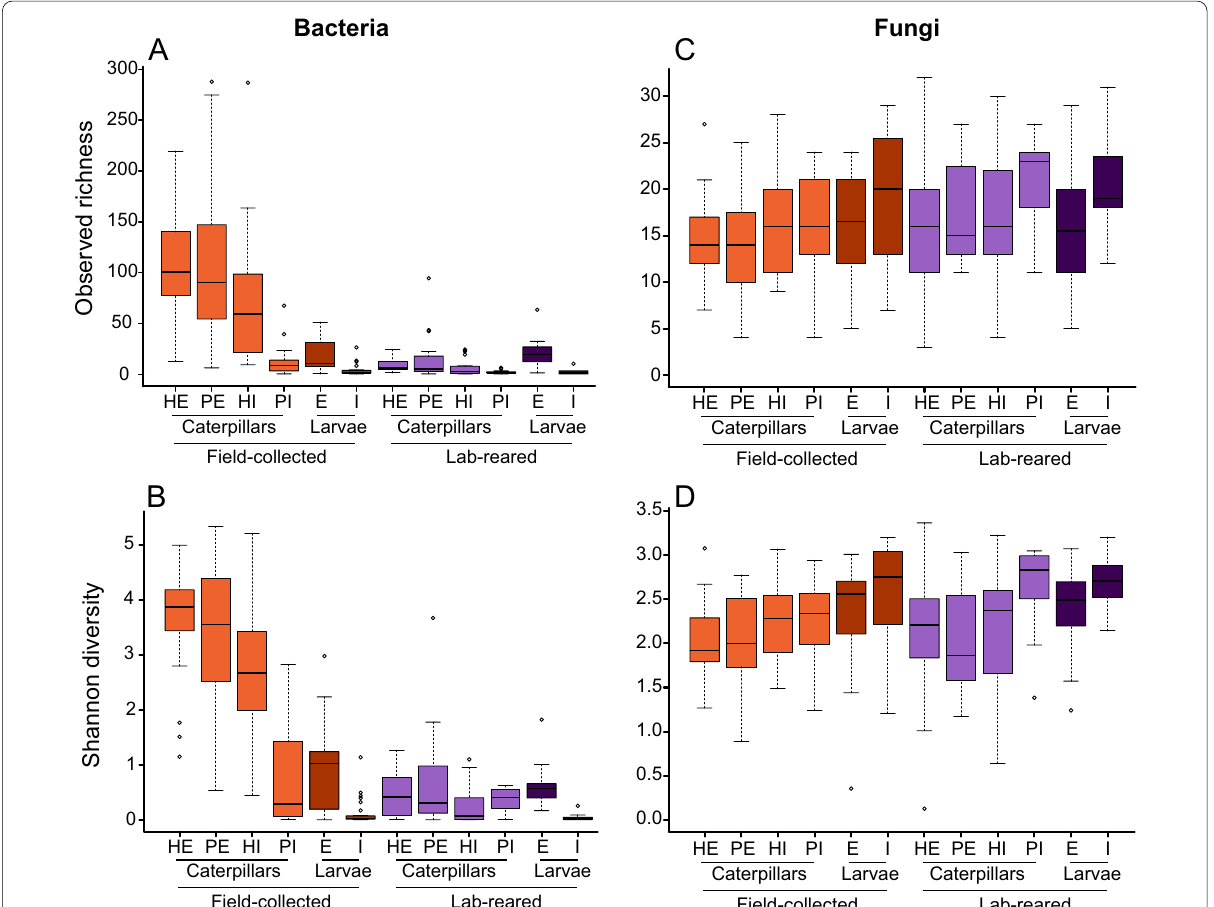
Fig. 1 Boxplots showing alpha diversity comparisons of the different caterpillars ( Pieris brassicae ) and parasitoid larvae ( Cotesia glomerata ) samples studied. Samples were divided in different subgroups according to habitat, health status and origin for caterpillars, and habitat and origin for parasitoid larvae. The upper and lower whiskers correspond to the first and third quartiles, with the bar in the middle marking the median value. Alpha diversity was measured by the number of observed of (z)OTUs (top panels) and Shannon index (bottom panels) for bacteria ( A , B ) and fungi ( C , D ). Abbreviations used: H healthy; P parasitized; E external; and I = = = =